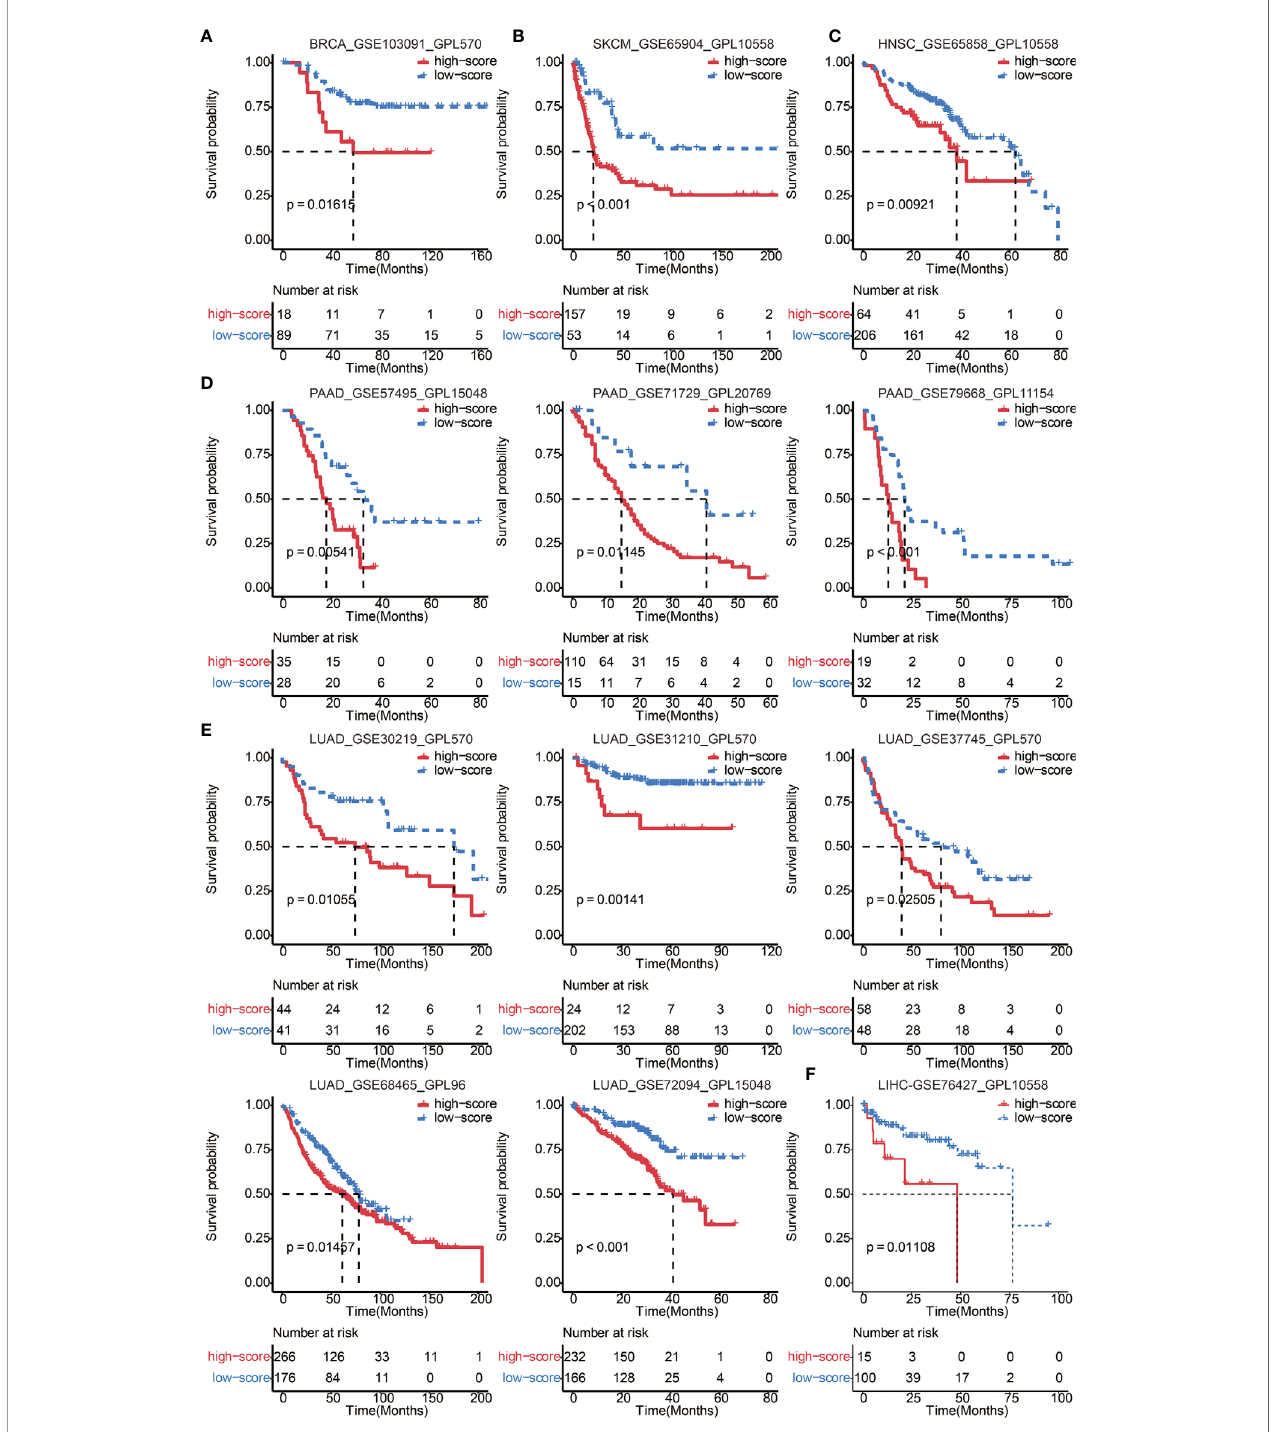
FIGURE 4 | Validation of ICP score in 6 representative cancer types. (A) Kaplan – Meier curves for the two ICP score groups in the BRCA dataset, GSE103091. Log- rank test, P = 0.01615. (B) Kaplan – Meier curves for the two ICP score groups in the SKCM dataset, GSE65904. Log-rank test, P < 0.001. (C) Kaplan – Meier curves for the two ICP score groups in the HNSC dataset, GSE65858. Log-rank test, P = 0.00921. (D) Kaplan – Meier curves for the two ICP score groups in the PAAD datasets, GSE57495, GSE71729, and GSE79668. Log-rank test, P = 0.00541, P = 0.01145, and P < 0.001, respectively. (E) Kaplan – Meier curves for the two ICP score groups in the LUAD datasets, GSE30219, GSE31210, GSE37745, GSE68465, and GSE72094. Log-rank test, P = 0.01055, P = 0.00141, P = 0.02505, P = 0.01457, and P < 0.001, respectively. (F) Kaplan – Meier curves for the two ICP score groups in the LIHC dataset, GSE76427. Log-rank test, P =